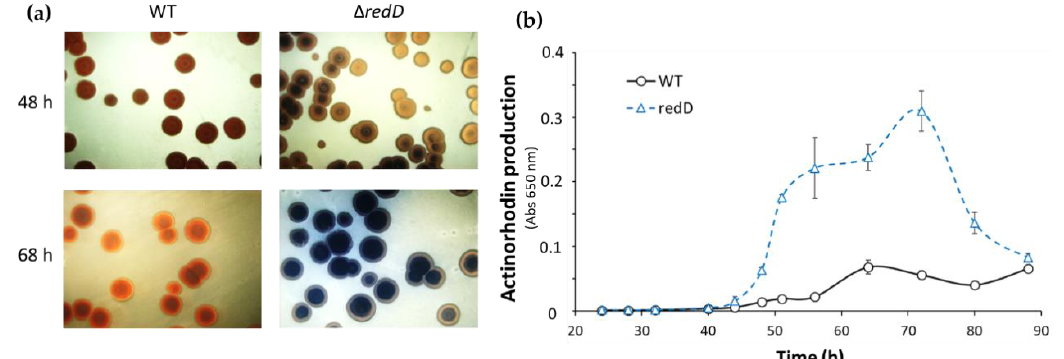
Figure 4. Comparison of actinorhodin production between S. coelicolor M145 (WT) and the ∆ redD mutant. ( a ) Production of the blue-pigmented actinorhodin on isolated colonies. Pictures show colonies from the reverse side of the plates. ( b ) Semi-quantitative assessment of actinorhodin production between S. coelicolor M145 (WT) and the ∆ redD mutant grown in R2YE agar plates.